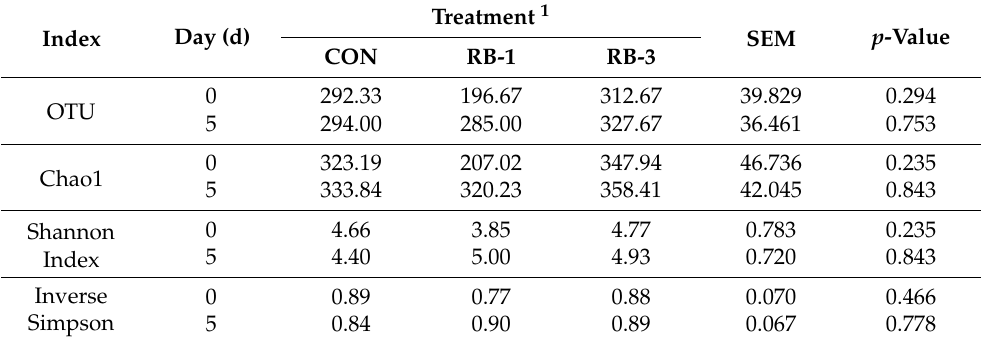
Table 2. Diversity of the microbial communities in rumen samples of Holstein Friesian cows supple- mented with different treatment over a 5-day feeding